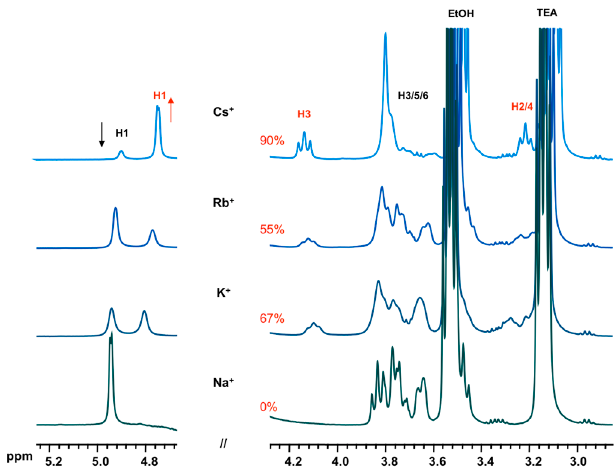
Figure 6. 1 H NMR spectra of equilibrated solutions in the system 1 α -CD:6 TEOS:6 TEAOH:900 D 2 O:40 XCl, X = Na, K, Rb, and Cs, which shows the dependence of D6R@ α -CD (ca. 4.1 ppm) on the nature of the alkali cation.